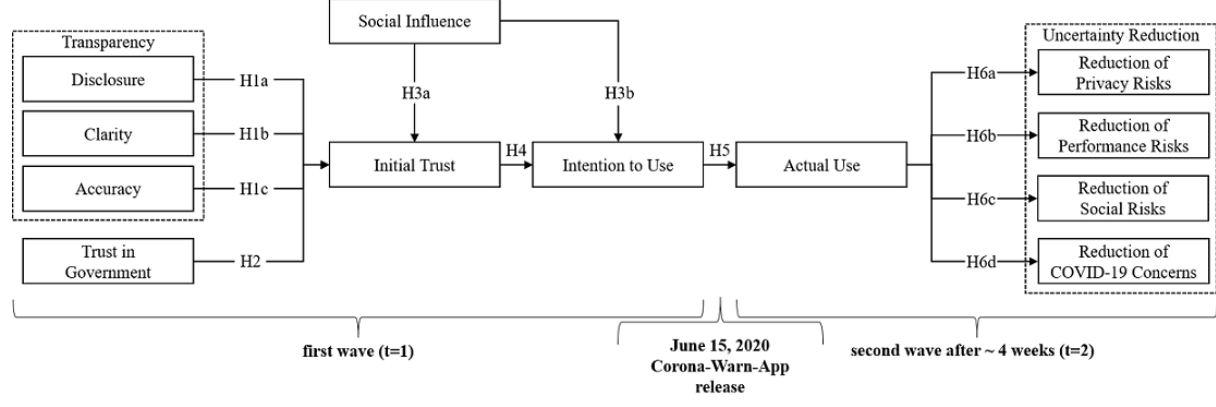
Figure 1. Proposed research model. H: